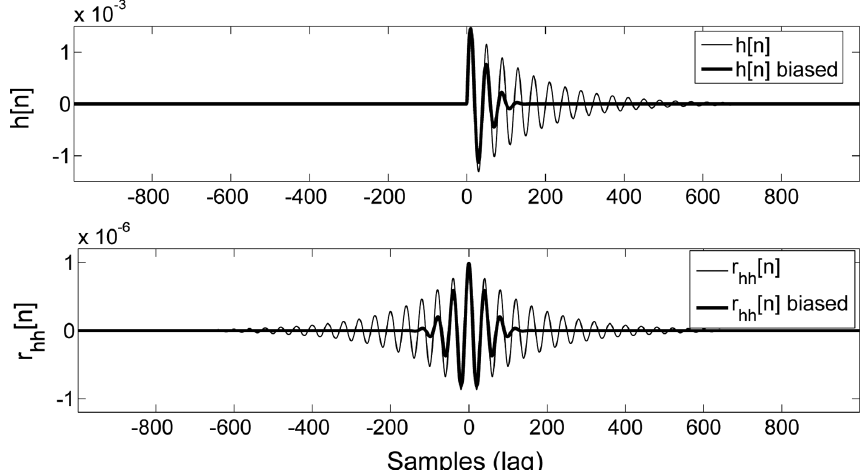
Fig. 1. The biased H 1 -estimate is obtained by taking the Fourier transform of a truncated impulse response (above). For the H 2 -estimate, the autocorrelation function of the impulse response is truncated (below) which gives a biased magnitude square function in frequency domain. The latter is then divided with the conjugate of the biased H 1 -estimate in order to obtain the H 2 -estimate. ˆ H 1 [ k ]